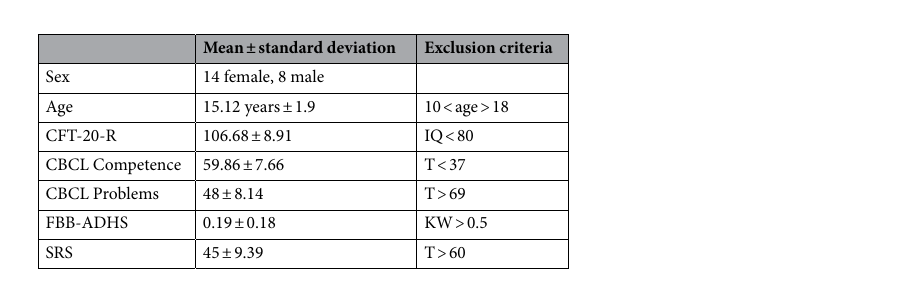
Table 1. Participants characteristics. CFT-20-R Grundintelligenztest Skala 2-Revision, CBCL child behavior checklist, FBB-ADHS Fremdbeurteilungsbogen für Aufmerksamkeitsdefizit-/Hyperaktivitätsstörungen, SRS social responsiveness